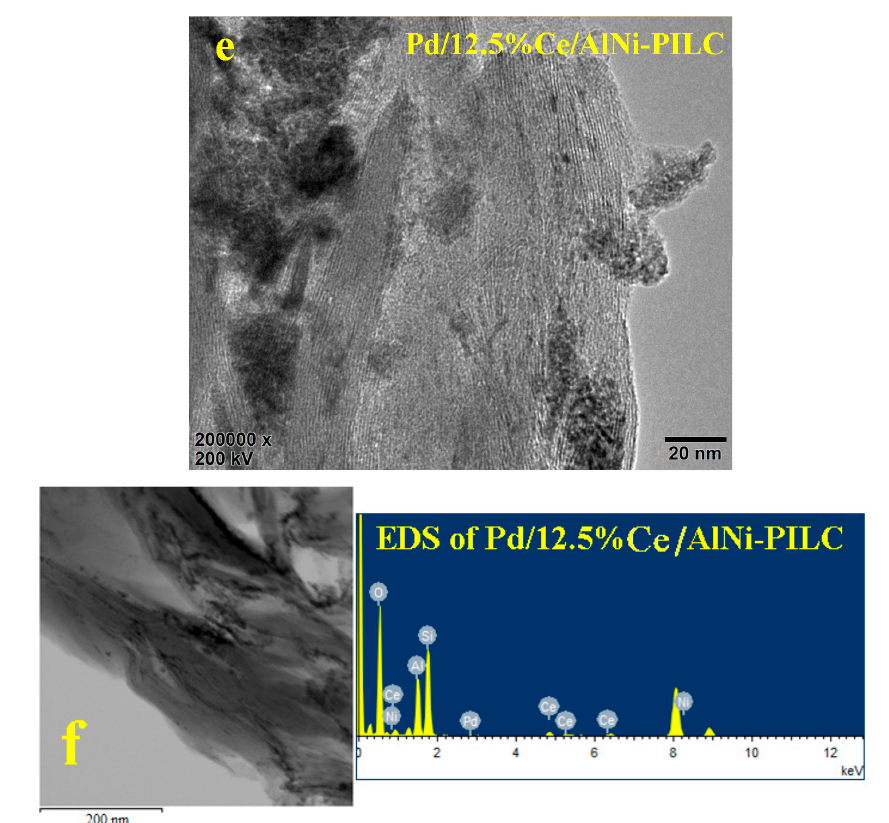
Figure 6. High resolution transmission electron microscopy (HRTEM) pictures. ( a ) MMT; ( b ) AlNi-PILC; ( c ) Pd/MMT; ( d ) Pd/AlNi-PILC; ( e ) Pd/12.5% Ce/AlNi-PILC; ( f ) the energy dispersive X-ray spectroscopy (EDS) spectra.